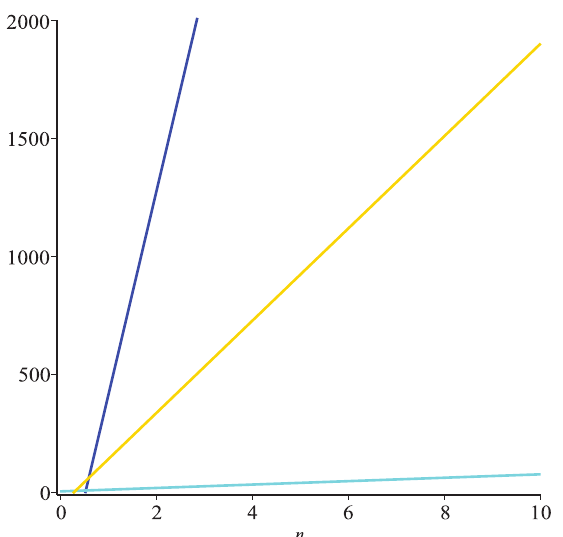
(G), RR (G)), and SSD (G) are a a